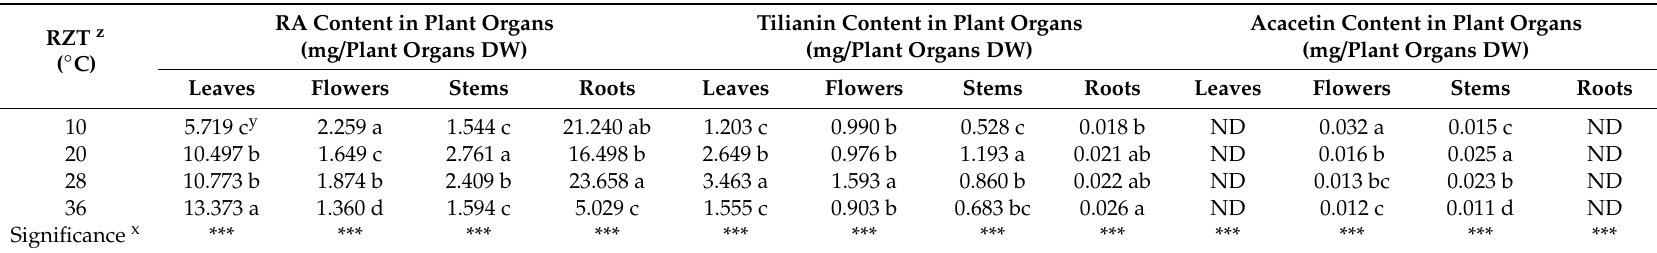
Table 3. Rosmarinic acid (RA), tilianin, and acacetin contents (mg / plant organs DW) in leaves, flowers, stems, and roots of A. rugosa grown at four di ff erent root zone temperature (RZT) treatments (10, 20, 28, and 36 ◦ C) at 32 days after transplant. RA Content in Plant Organs RZT z (mg / Plant Organs DW) ( ◦ C) Leaves